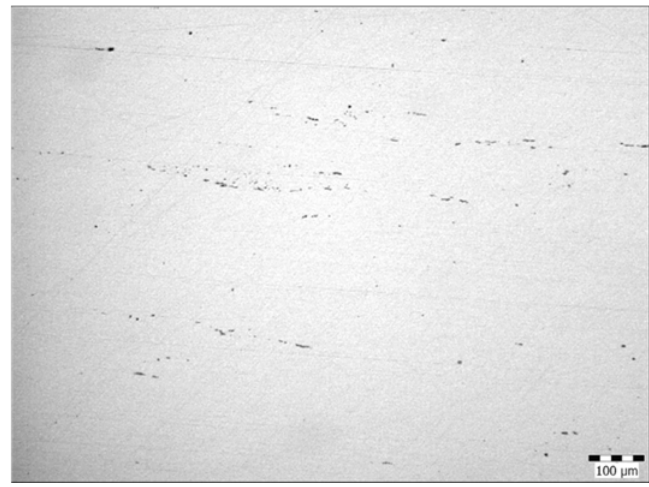
Figure 8. An example of sulfides in the CMnCr steel with 0.08 wt. % of Bi. Electron microscopic analysis of Bi-free CMnCr steel revealed numerous clusters of both elongated gray particles and various dark particles. Using X-ray microanalysis, their chemical composition was identified as manganese sulfides and aluminum oxides. The characteristic Energy dispersive X-ray spectra (EDX) of these particles are shown in Figure 9, and their composition in Table 3.